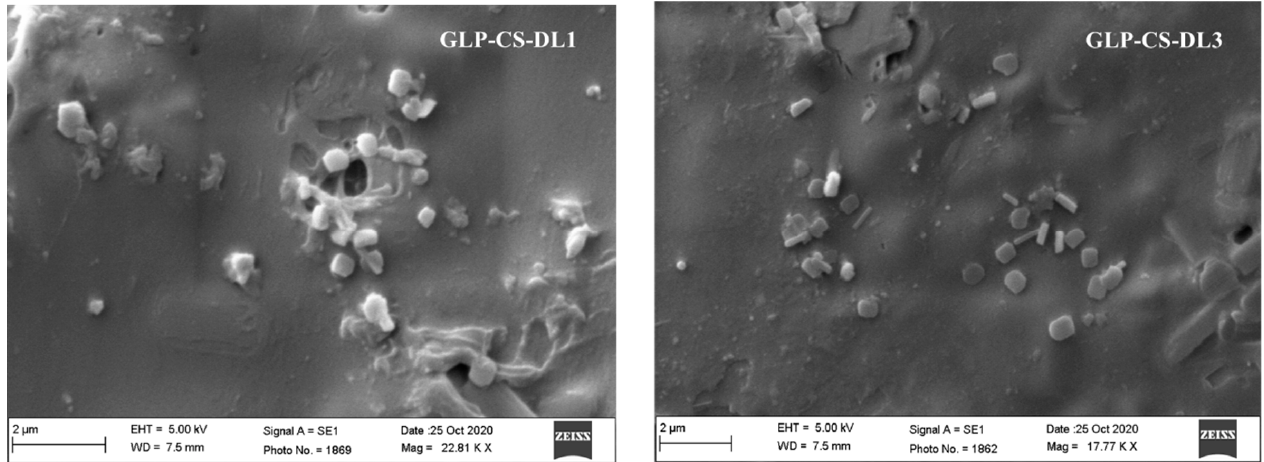
Figure 5. SEM of transdermal films of GLP-CS-DL1 and GLP-CS-DL3.